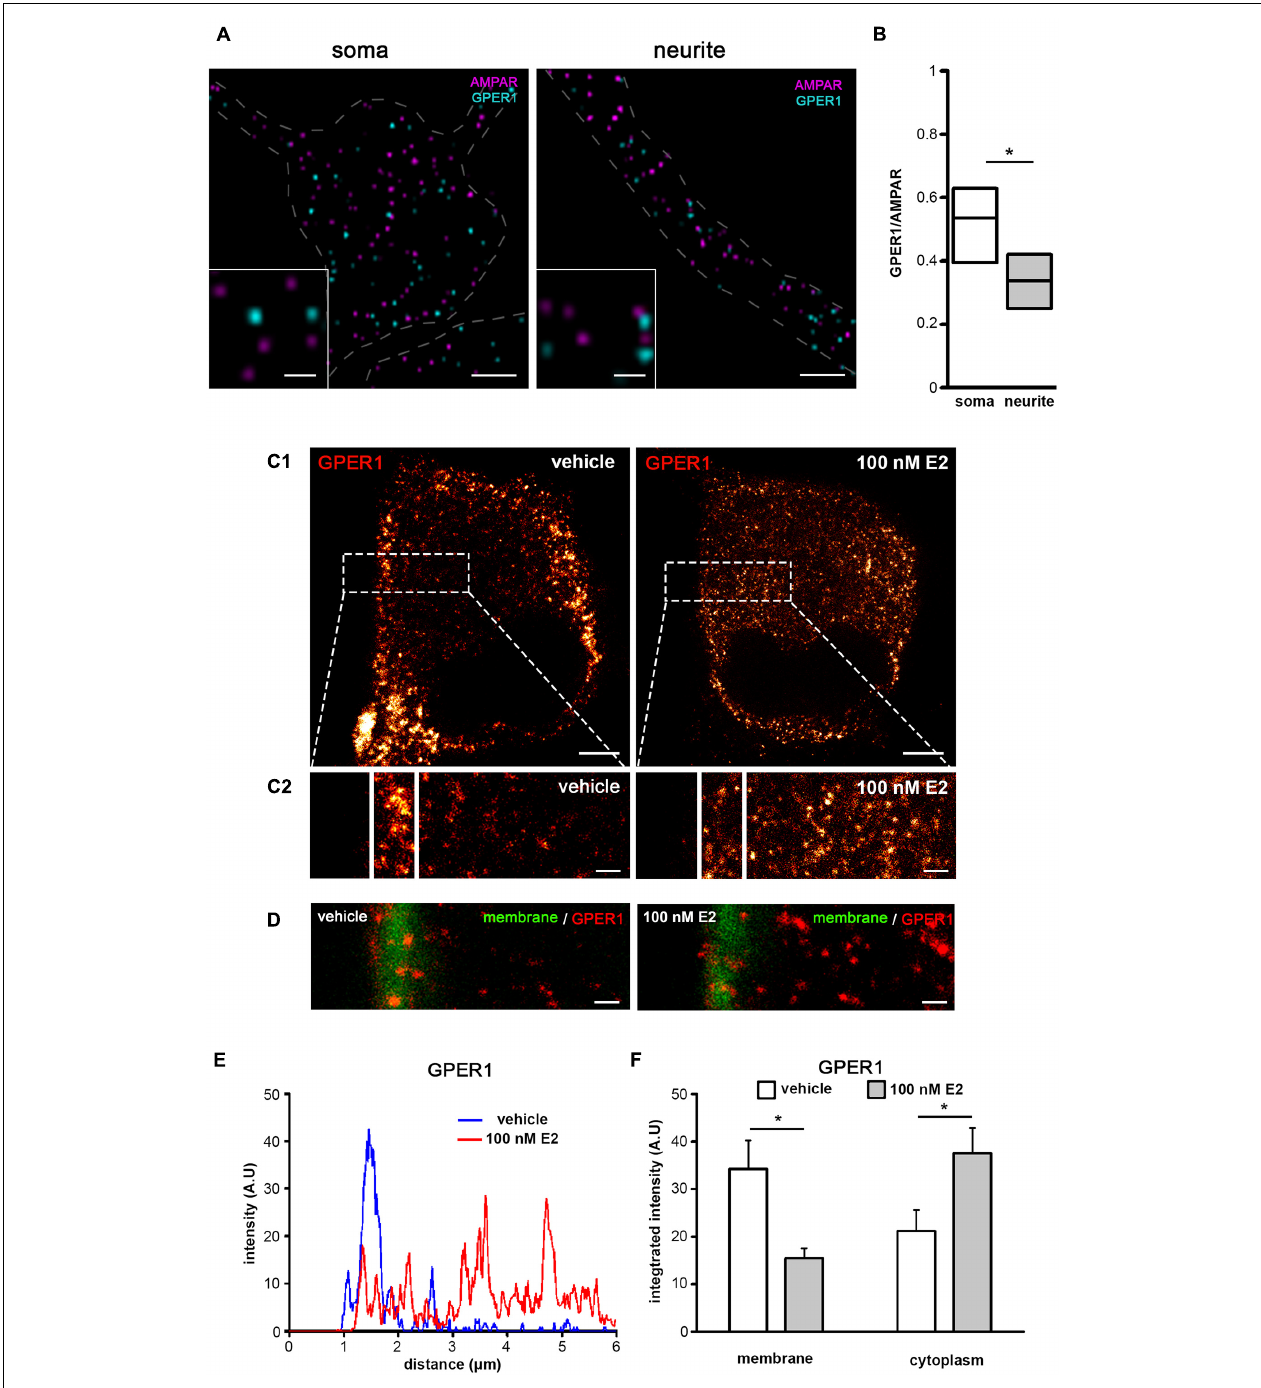
FIGURE 4 | The GluR2-AMPAR/GPER1 ratio and molecular distance between GPER1 and GluR2-AMPAR in the membrane. (A) STORM images depicting immunolabeled AMPAR (magenta) and GPER1 (cyan) molecules on dPC12. Dashed lines delineate the borders of the neurites and somas. Scale bar = 2 µ m; inset Scale bar = 0.5 µ m. (B) The ratio between the number of GPER1 and AMPAR molecules (GPER1/GluR2-AMPAR) on the neurites and somas ( n = 11 somas or neurites). (C1) Photomicrographs depict GPER1 immunoreactivity (visualized with STED microscopy) in dPC12 after 10 min of vehicle (left) or of 100 nM of E2 treatment (right). Scale bar = 2 µ m. (C2) One 2 µ m 2 (between parallel white bars) and one 10 µ m 2 (to the left) areas were selected within each ROI for the membrane and cytoplasmic regions of each cell, respectively. Integrated density was calculated and normalized to the area. Scale bar = 0.5 µ m. (D) Dual labeling of plasma membrane and GPER1 molecules defines the membrane regions (approximately 1 µ m wide). Scale bar = 0.5 µ m. (E) Line graph of the fluorescent intensity calculated from the magnified STED inserts (C2). (F) Integrated density graphs of GPER1 show the effect of vehicle and 100 nM of E2 treatment in the membrane and in the cytoplasm ( n = 15 cells were evaluated in each group). * p < 0.05.